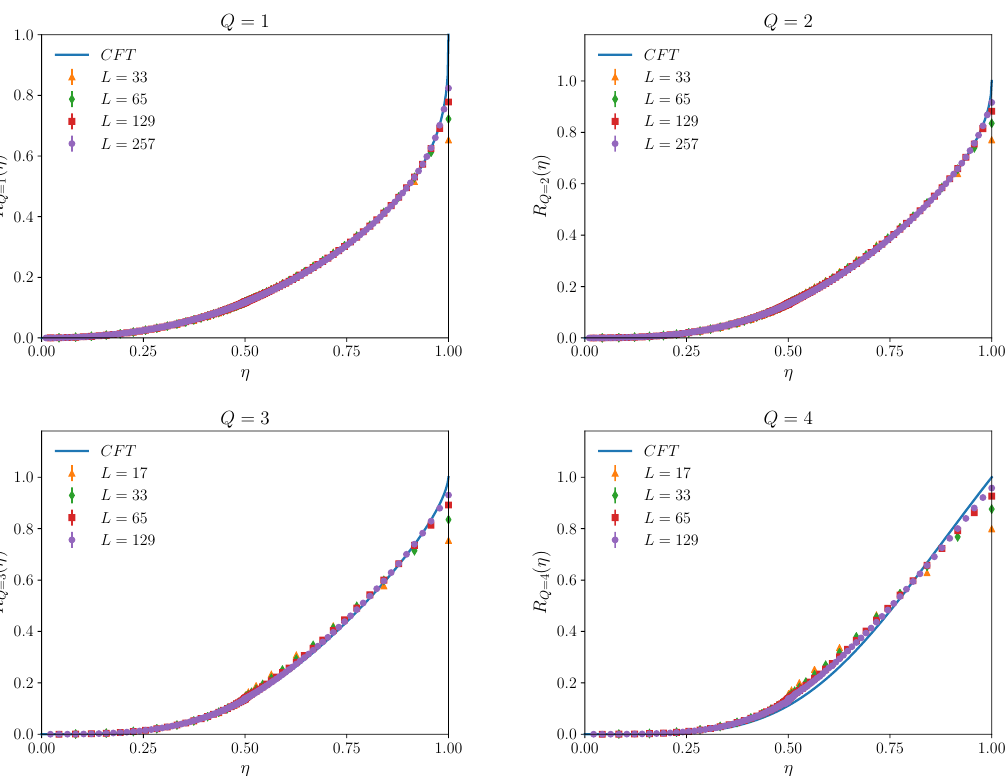
Figure 5 . The plots refer to percolation (top left), Ising (top right), three color (bottom left) and four color Potts (bottom right) model respectively and show the results of Monte Carlo simulations for the ratio R MC for sizes L = 33, 65, 129, 257 for Q = 1, 2 and L = 17, 33, 65, 129 for Q = 3, 4 Q together with the theoretical CFT predictions R CFT